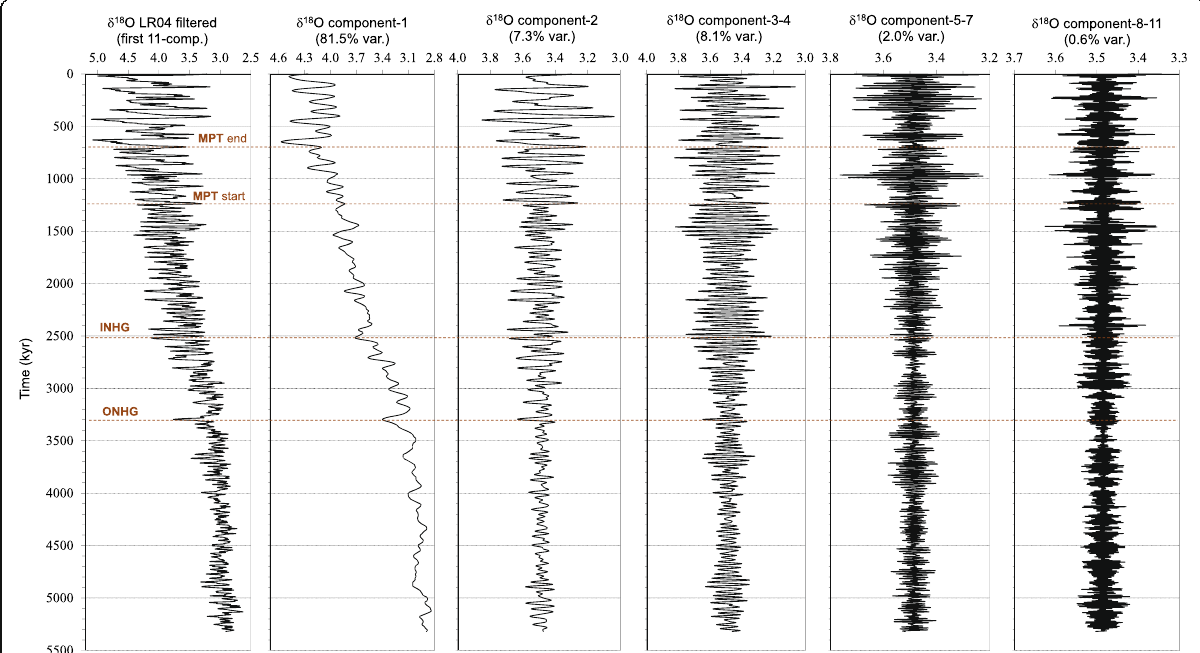
Fig. 1 Time-series panel of the five δ 18 O components isolated from the LR04 signal by singular spectrum analysis, together with the LR04-filtered record (left) obtained by combining these data components (99.5% total variance). The x -axis scale ( ‰ ) is variable in relation to the variance fraction of the data components. Original LR04 δ 18 O data from Lisiecki and Raymo (2005b) resampled at 1 kyr. Time scale in